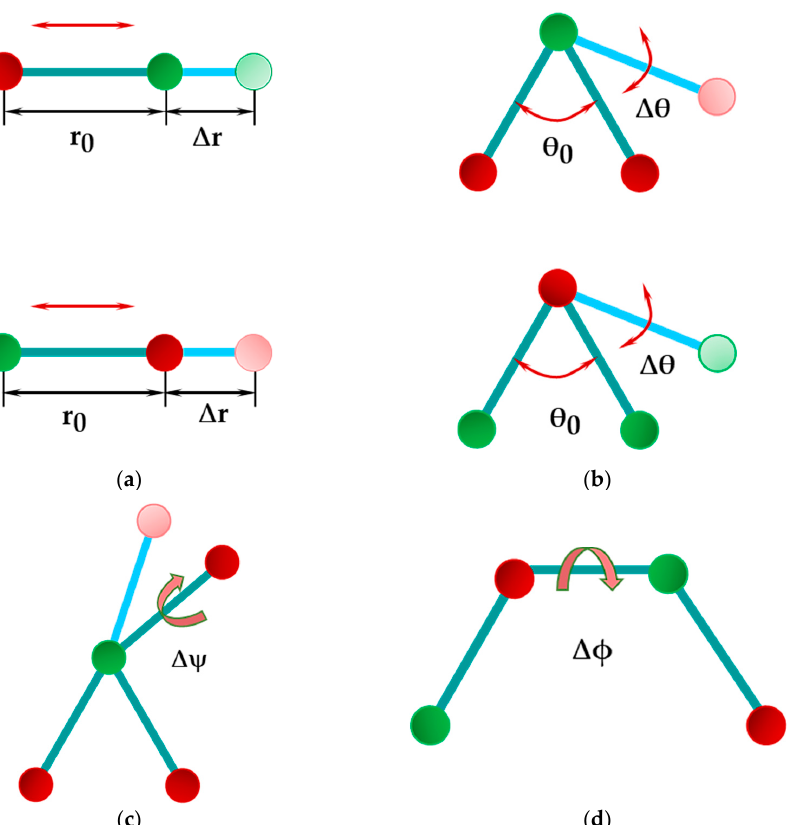
Figure 3. Bond interactions in 13th element phosphide nanostructures: ( a ) bond stretching; ( b ) bond bending; ( c ) dihedral torsion; ( d ) out-of-plane torsion or inversion. P atoms are in green; A13 (B, Al, Ga, In) atoms are in red.